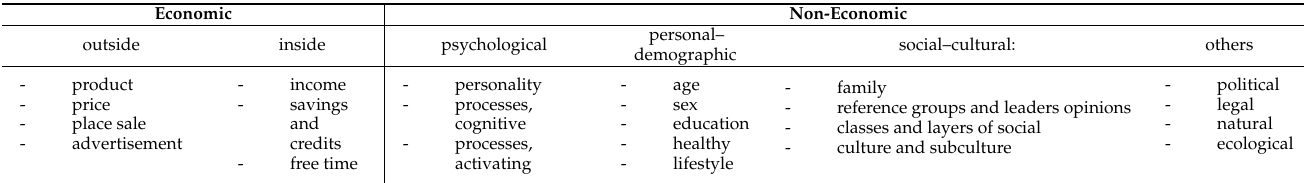
Table 1. Factors affecting consumer behaviour in the tourism